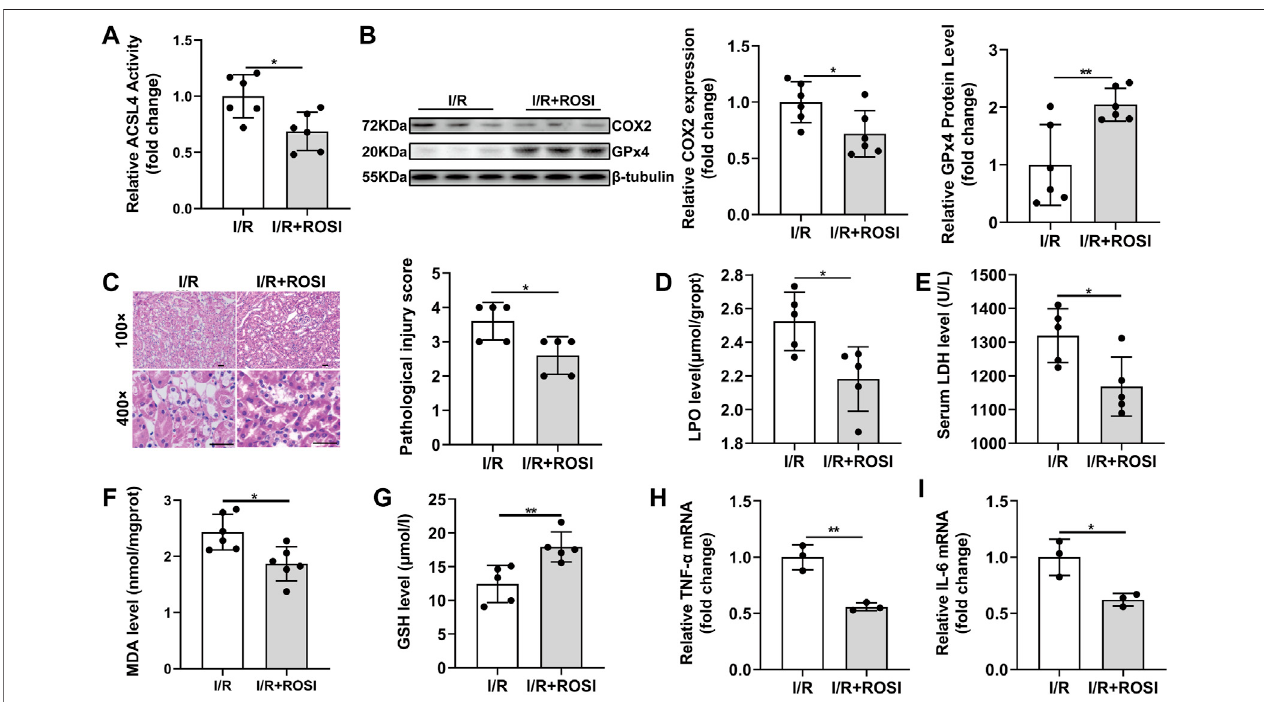
FIGURE 4 | ROSI attenuates ferroptosis-mediated damage and in fl ammation during renal I/R. (A) ACSL4 activity ( n = 6). (B) Western blot analysis of COX2 and GPx4 in the renal tissue ( n = 6). (C) Representative H&E staining (original magni fi cation, ×100 or × 400, scale bar = 20 μ m) and corresponding relative renal injury score ( n = 5). (D) LPO production ( n = 5). (E) Serum LDH levels ( n = 5). (F – G) MDA and GSH levels in renal homogenates ( n = 5). (H,I) Expression of TNF- α mRNA and IL-6 mRNA from renal tissue of I/R determined by qRT-PCR analysis ( n = 5). The data are the Means ± S.D., * p < 0.05, ** p <